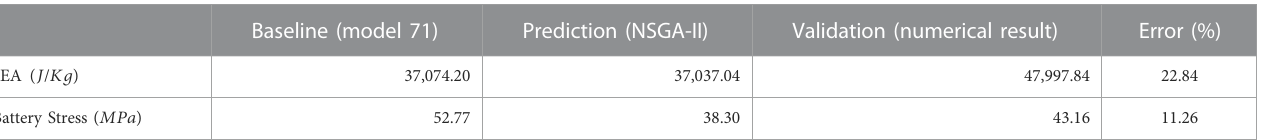
TABLE 6 Validation and comparison of optimum